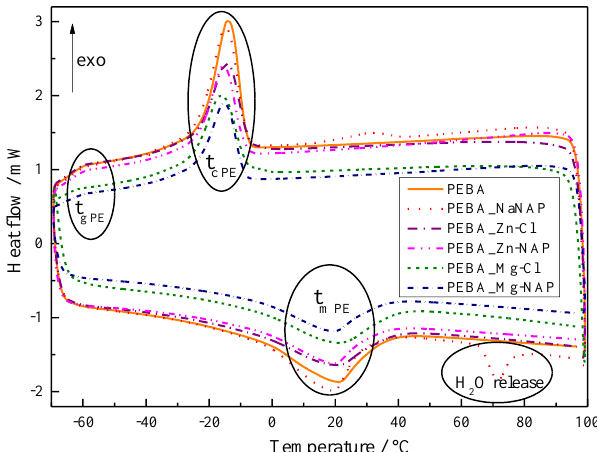
Figure 5. Cooling (top) and second heating (bottom) differential scanning calorimetry (DSC) scans for pristine PEBA and PEBA composites. T g PE —glass transition temperature of PE portion, T c PE — crystallization temperature of PE portion, T m PE —melting temperature of PE portion.